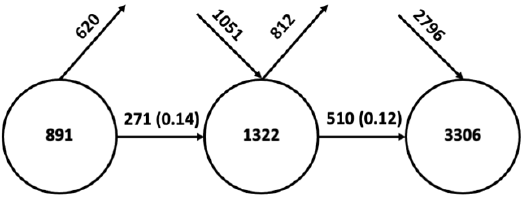
Figure 7. Overlay graph of the research field.